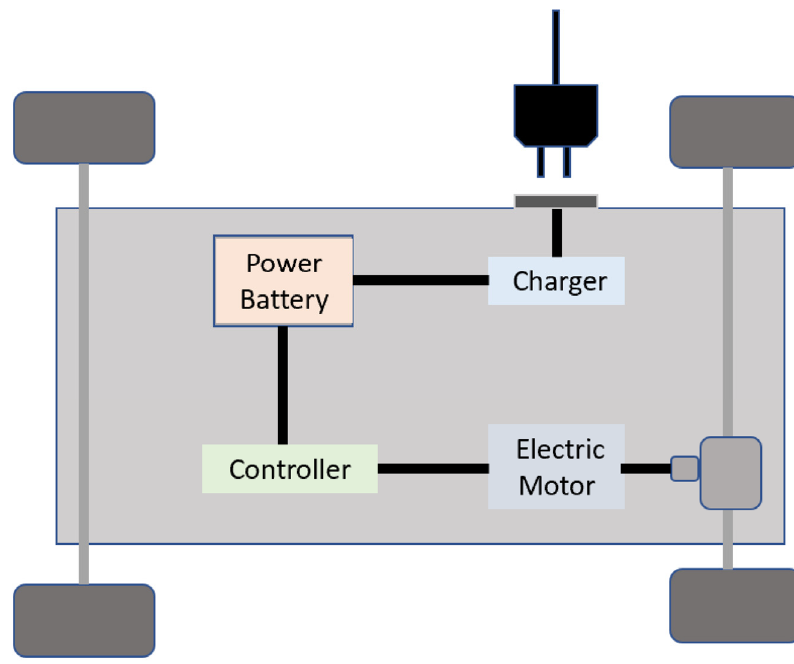
Figure 4. A battery-powered electric vehicle design